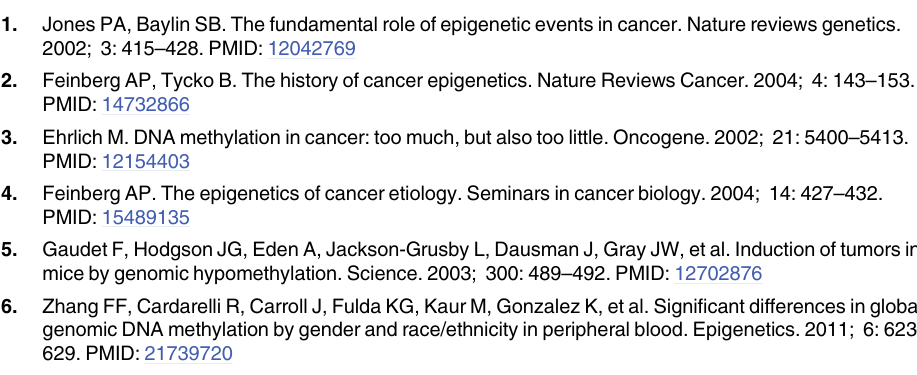
S1 Table. Title: Age, MNC+ and LINE-1 data. Legend: “ Data file Cho et al. xlsx ” contains information on age, MNC+ and LINE-1 methylation, which were measured using the micro- nucleus-centromere and pyrosequencing assays as described in the paper. Also, the data file provides information on the smoking and drinking status of individuals used in the